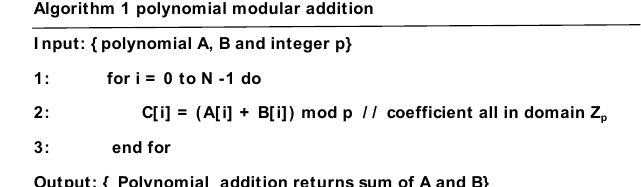
Fig. 1. polynomial modular